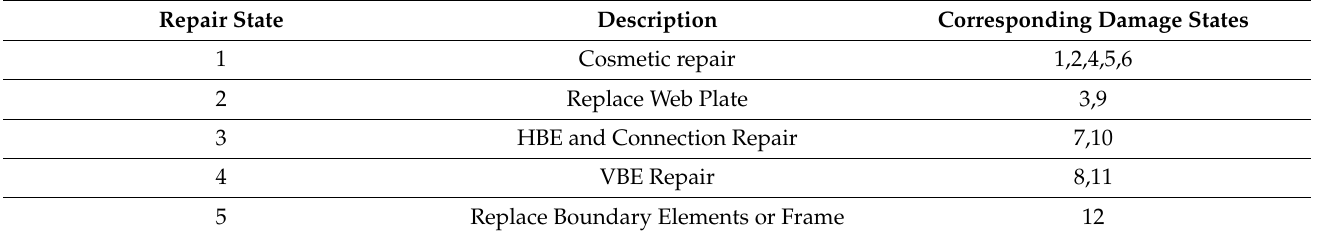
Table 3. Repair states and corresponding damage